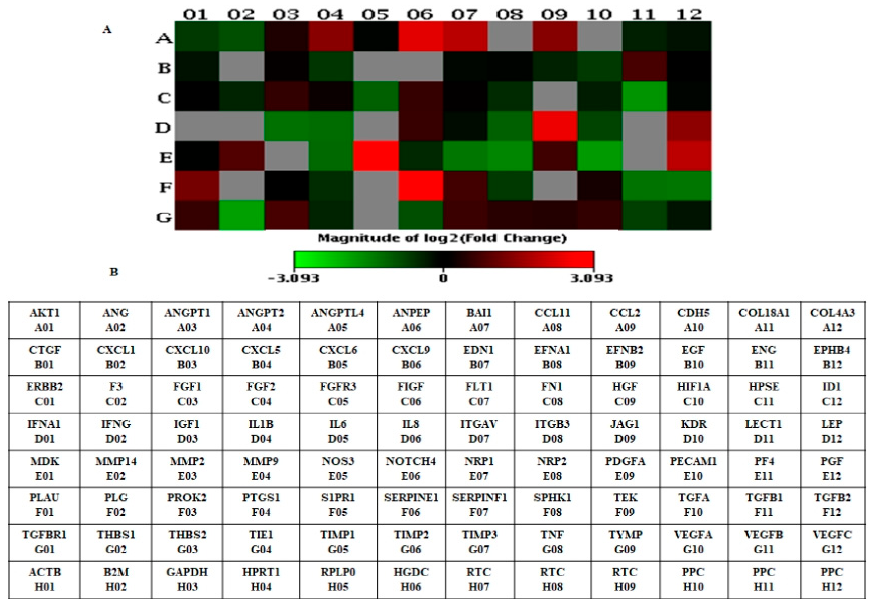
Figure 2. ( A ) Heat map showing differentially expressed genes in LNCaP-MST cells after Nutlin-3 treatment. ( B ) Human angiogenesis gene table (PAHS-024Z) used in RT 2 profiler PCR array experiments.